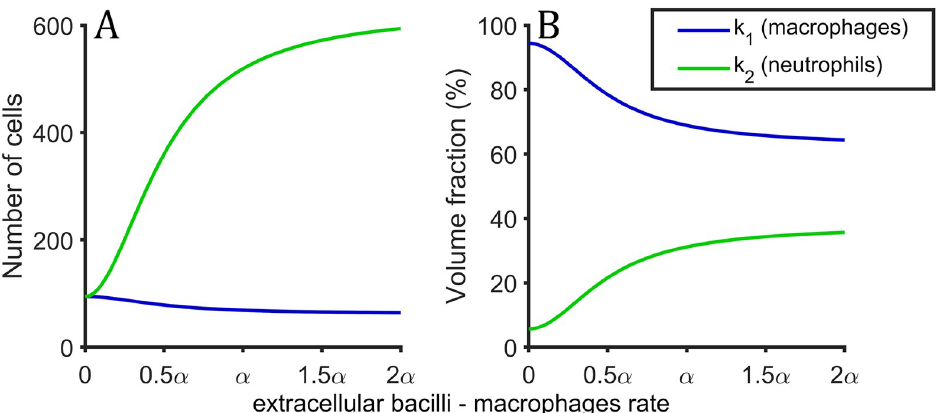
Fig 2. Inflammatory response profile. Profile of the inflammatory response as a function of extracellular bacilli and total amount of macrophages. (A) Number of cells that enter per day at the alveoli when inlfammatory response is fully activated. (B) Volume fraction of macrophages (blue) and neutrophils (green) that enter in alveoli due to inflammatory